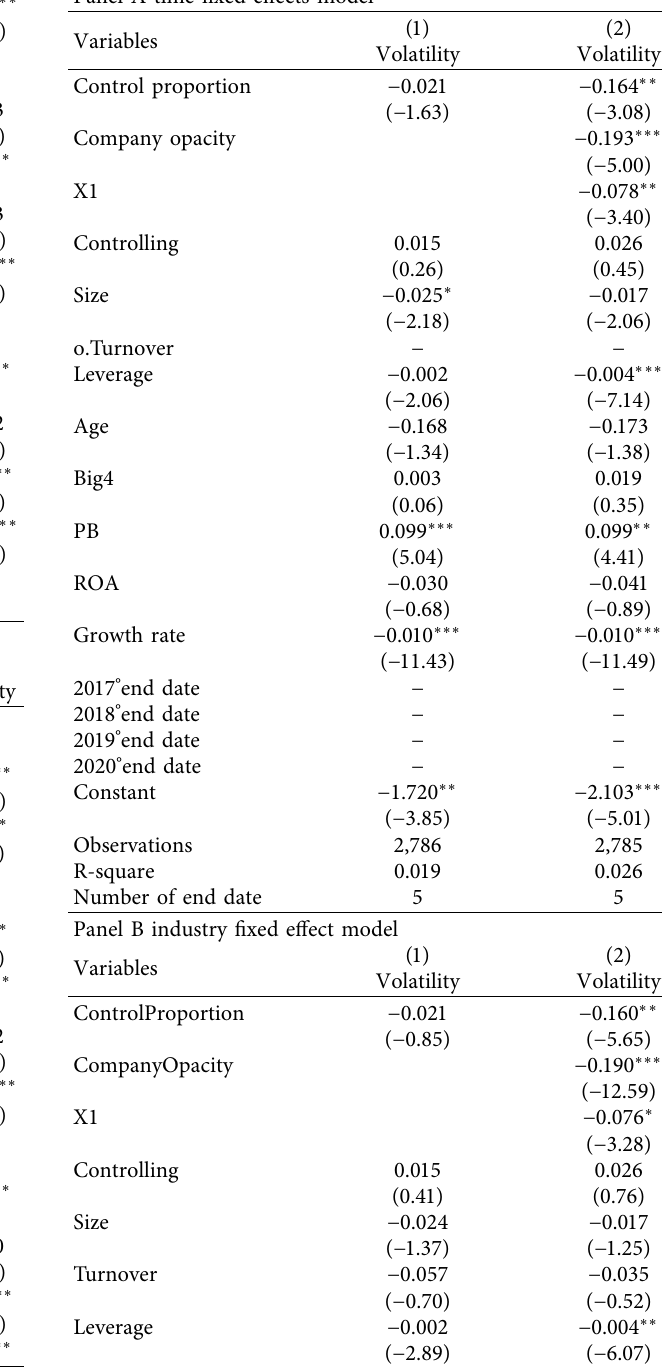
Table 8: The robust checks using fixed effect model to reduce the endogenous issue. Panel A and Panel B show the results for time fixed effects model and industry fixed effect model,